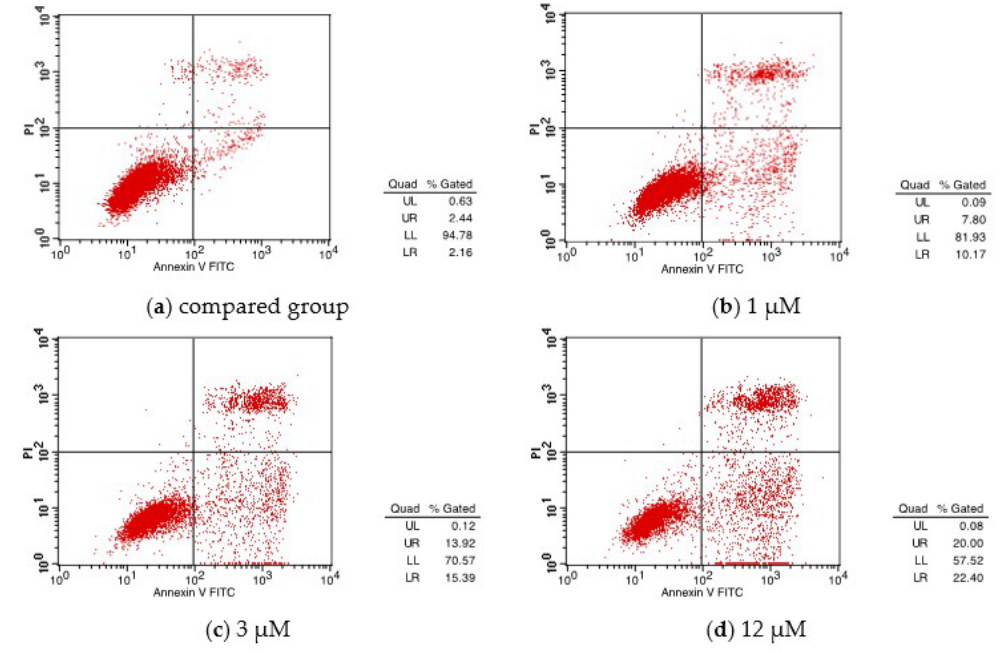
Figure 5. Different concentration of compound 4 of ( a ) compared group, ( b ) 1 µM, ( c ) 3 µM and ( d ) 12 µM effect on the HepG2 cell cycle of humans. x -axis: Channels (FL2-A); y -axis: Number. Red zone from left to right: Dip G1 and G2; middle blue cross-court zone: Dip S.